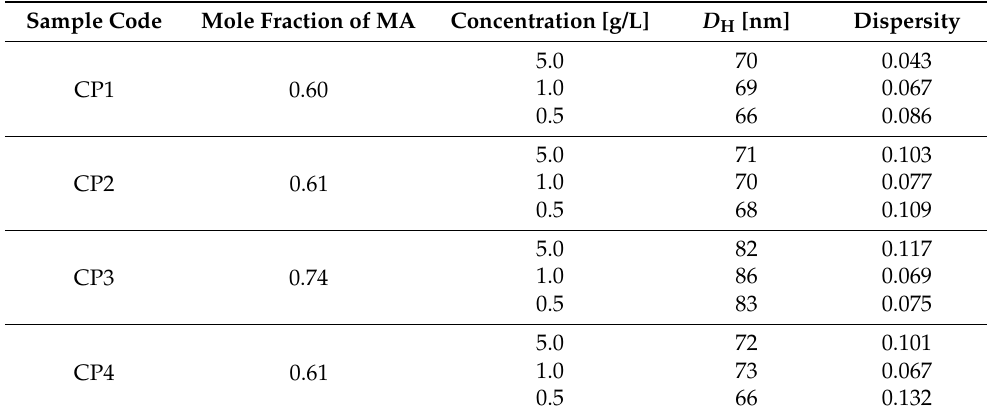
Table 2. Particle size and size distribution of PVA- g -PMA colloidal aqueous dispersions at different copolymer